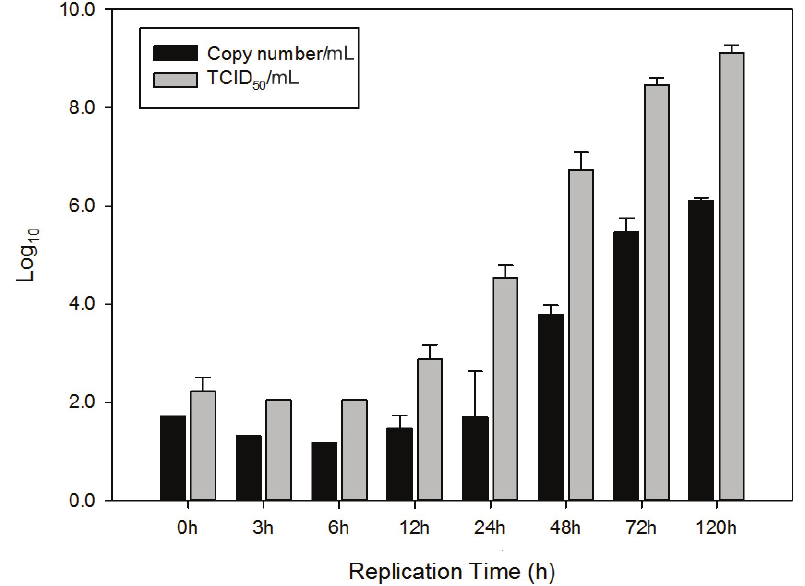
Figure 2. Comparison of VHSV titer (TCID indicates log values of the VHSV copy number and gray bar indicates log values of VHSV titer (TCID 50